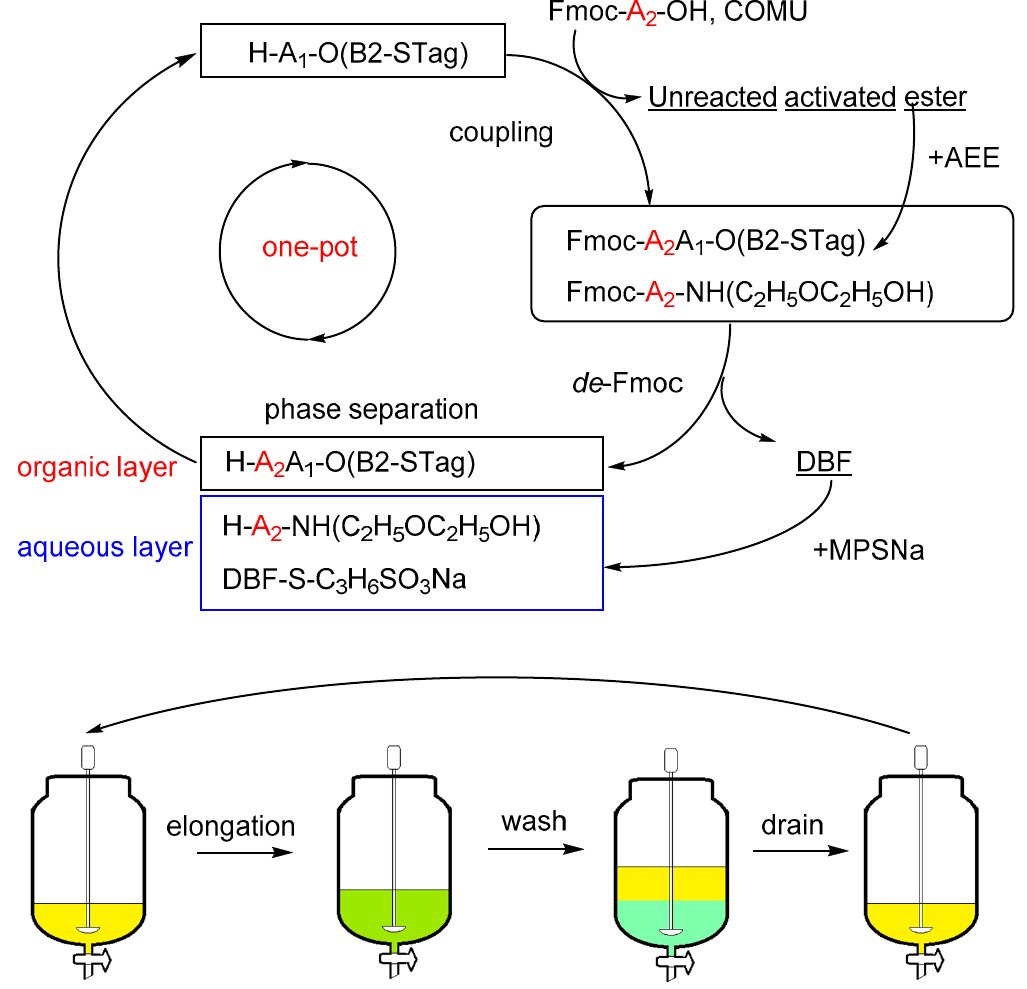
Figure 3. The STag-PS platform developed for continuous one-pot elongation.